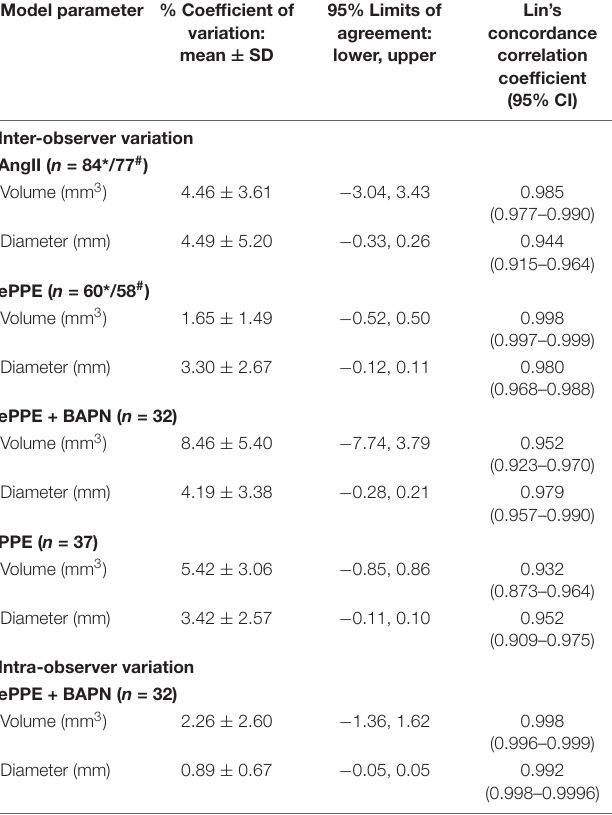
TABLE 1 | Evaluation of reproducibility between two independent observers (inter-observer variation) in the AngII, ePPE ± BAPN and PPE model regarding 3D US measurements of AAA volume (mm 3 ) and maximum aortic diameter